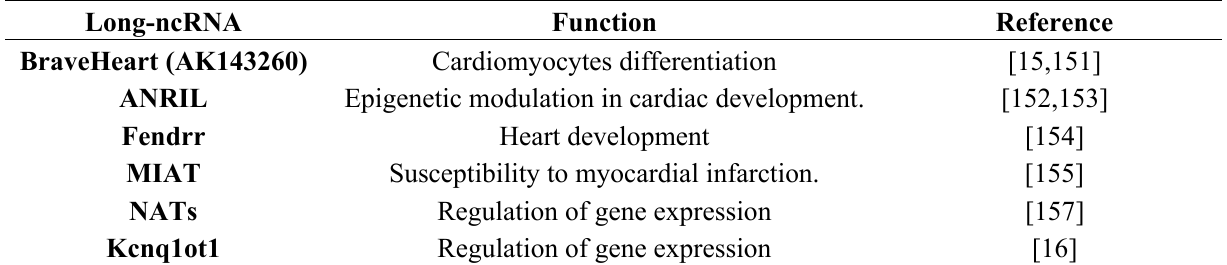
Table 2. Long-ncRNA in Heart Development and